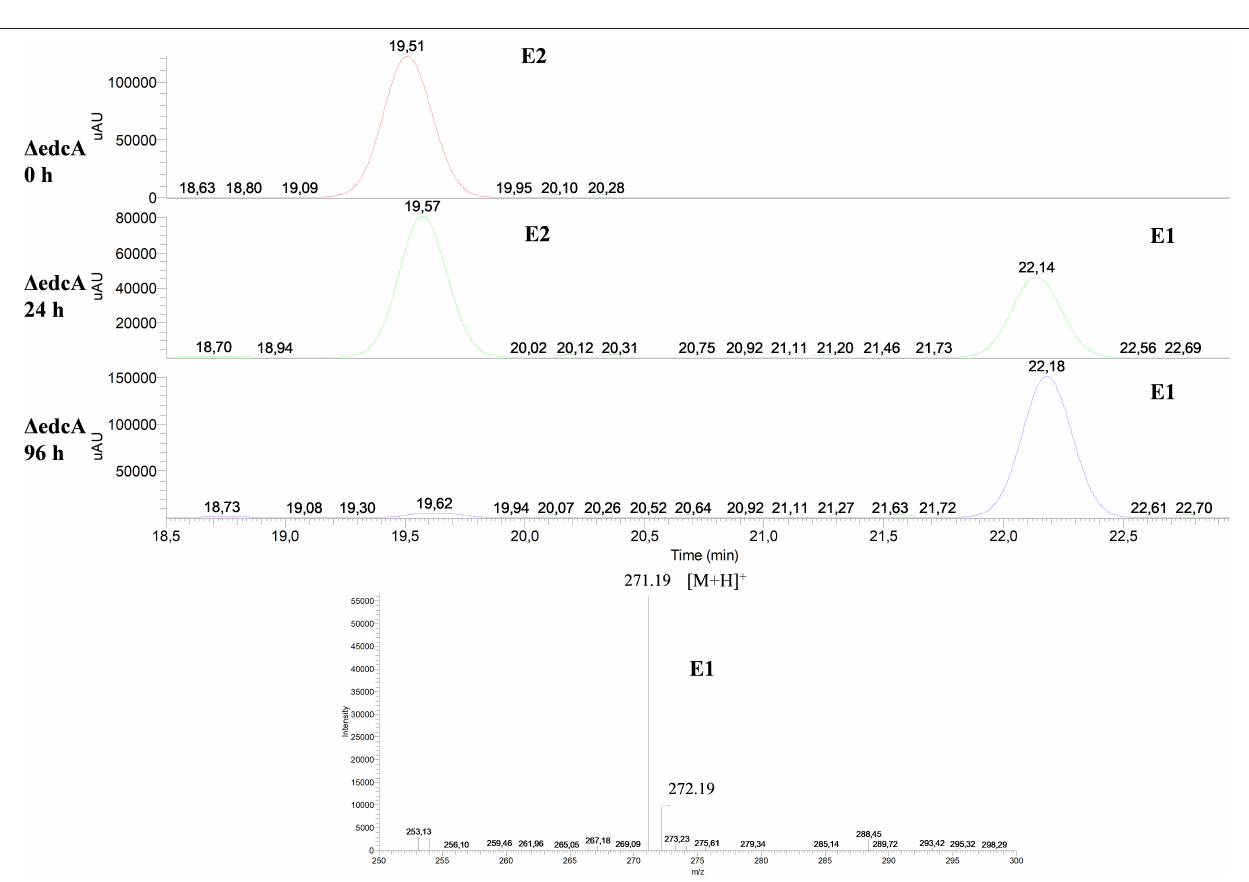
ligates a CoA molecule to the resulting new carboxylic residue to facilitate further degradation (Wu et al., 2018). In the absence of this enzyme, the resulting meta -cleavage product of ring